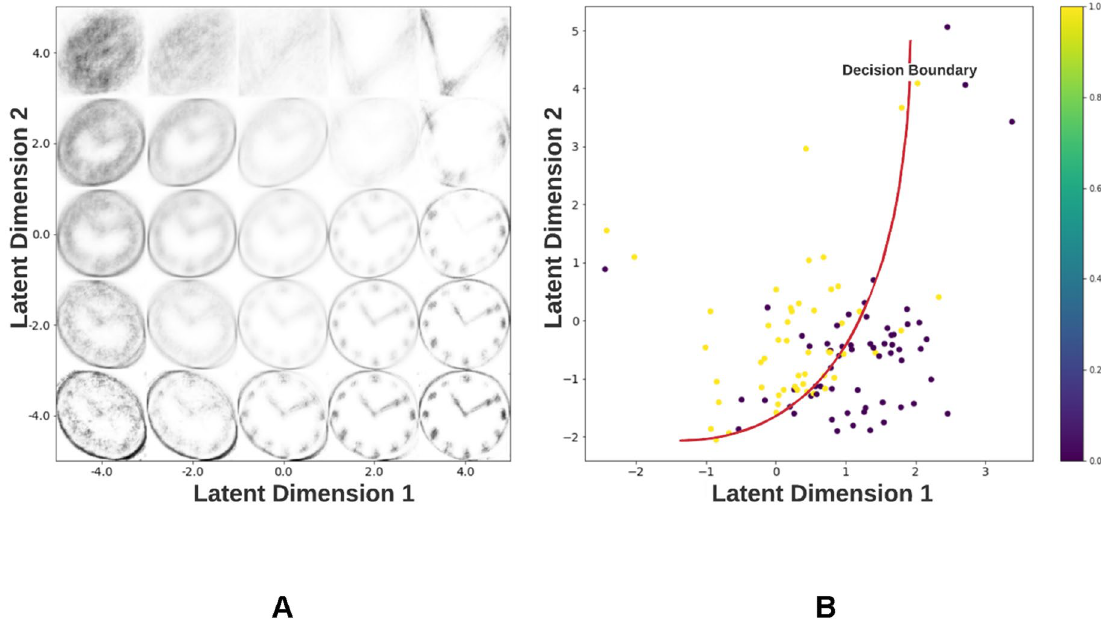
Figure 1. Distribution of reconstructed clocks in the VAE latent space. ( A ) Clock drawing reconstructions are represented as a function of the two VAE latent dimensions. This shows the variety of reconstructions generated by the VAE to capture the distribution of the training dataset. ( B ) Scatterplot showing the distribution of the latent vectors belonging to clocks in the fine-tuning dataset divided into dementia (= 1) and control (= 0) groups. The red curve represents a possible decision boundary between the two groups. Using our neural network classifier, we aim to learn such a decision boundary to classify the two Classification dataset (fine‑tuning cohort). Figure 1A illustrates the reconstructions of clock drawings performed by the VAE as a function of its latent variables. The smooth transition between the reconstructed clocks observed here results from the normal distribution to which the VAE latent variables are restricted. Fig- ure 1B shows the distribution of reconstructions of dementia/control clocks from the fine-tuning dataset as a function of their latent space vectors. The scatterplot shows visible separation between dementia and control clocks. The reconstructions denote that features which are salient for human perception such as digits and ticks are not captured by the VAE latent space. Instead, the VAE latent space captures statistical features of clock drawings such as eccentricity, size, size of clock hands and distance of clock hands from the geometric center (Fig. 2). These features are correlated to the two latent dimensions of the VAE latent space and are mutually entangled in this space. The latent manifold upon which the trained VAE projects clock drawings is a two-dimensional vector space that can be functionally divided into five regions which delineate the variation of different clock drawing features and anomalies. Figure 2 shows a traversal over these five regions. The VAE had no prior information about the generative features of clock drawing. Therefore, the clock features appear in an entangled/mutually correlated manner in the two-dimensional latent space of the VAE. Latent dimensions. The first latent dimension (plotted along the X-axis) is abbreviated as Z0, and the second latent dimension (plotted along the Y-axis) is abbreviated as Z1. The left half of the latent manifold space (Z0 < 0) is concerned with the direction of the eccentricity of a clock drawing (Fig. 2, Supplementary Video V1). The eccentricity reverses from left to right as Z1 given Z0 (Z1|Z0) changes from − 4 to + 4, passing through a point of zero eccentricity (circular clock at Z1|Z0 = 0). The size of the clock drawing is a correlated variable which decreases as Z1|Z0 increases from − 4 to + 4 in the left half of the two-dimensional manifold. On the other hand, the right half of the latent manifold (Z0 > 0) is related to the distance of the point of intersection of clock hands from the clock’s geometric center (Fig. 2, Supplementary Video V2). The point of intersection of clock hands moves downwards from the geometric center as Z1|Z0 traverses from − 4 to + 4 in this region. This change is also associated with a loss of the circular periphery of the clock which is an important anomaly present in clocks drawn by patients with advanced stages of dementia. The top of the latent space (Z1 > 0) encodes an increasing length of clock hands; and distance of point of intersection of clock hands to geometric center mixed with each other (Fig. 2, Supplementary Video V3). Length of clock hands and area of the clock face increase as Z0|Z1 changes from − 4 to + 4. The bottom half of the latent space (Z1 < 0) encodes the eccentricity of the clockface (Fig. 2, Supplementary Video V4). Eccentricity decreases as Z0|Z1 changes from − 4 to + 4 in this region of the latent space. Furthermore, this feature is interlinked with an increase in clockface area as Z0|Z1 changes from − 4 to + 4 in this region. Finally, the X-axis which traces the change in Z0|(Z1 = 0) purely encodes the size of the clockface, evident from the increasing clarity of the clock drawing along this line (Fig. 2, Supplementary Video V5).